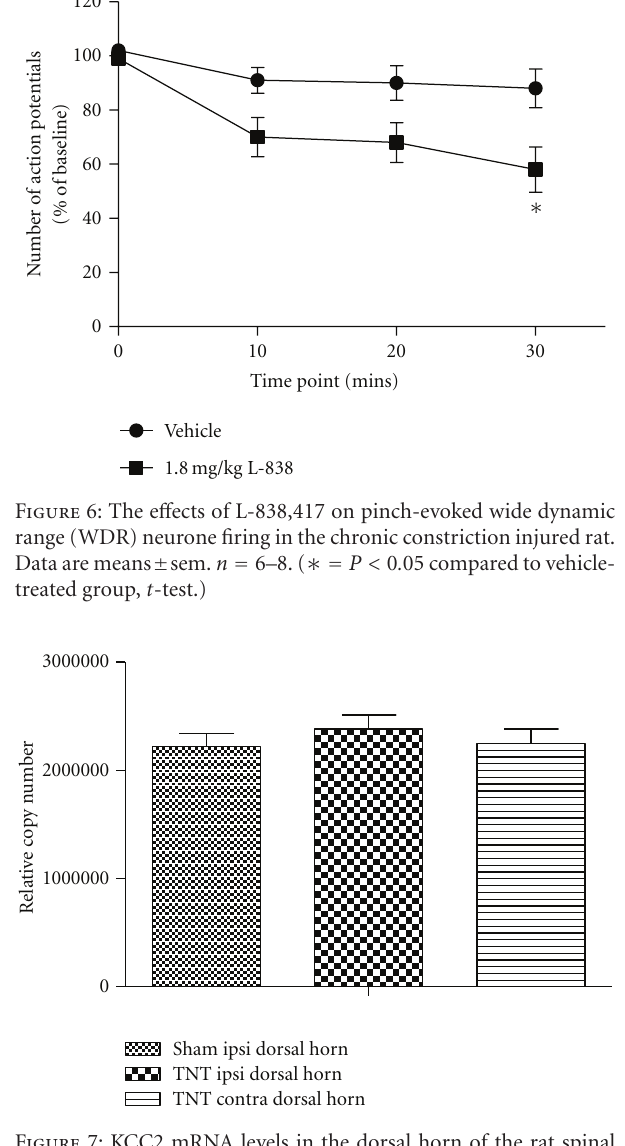
Figure 7: KCC2 mRNA levels in the dorsal horn of the rat spinal cord following either chronic constriction injury (CCI) or sham surgery. Data are means ± sem. n = 18. Ipsi: ipsilateral. Contra: contralateral.